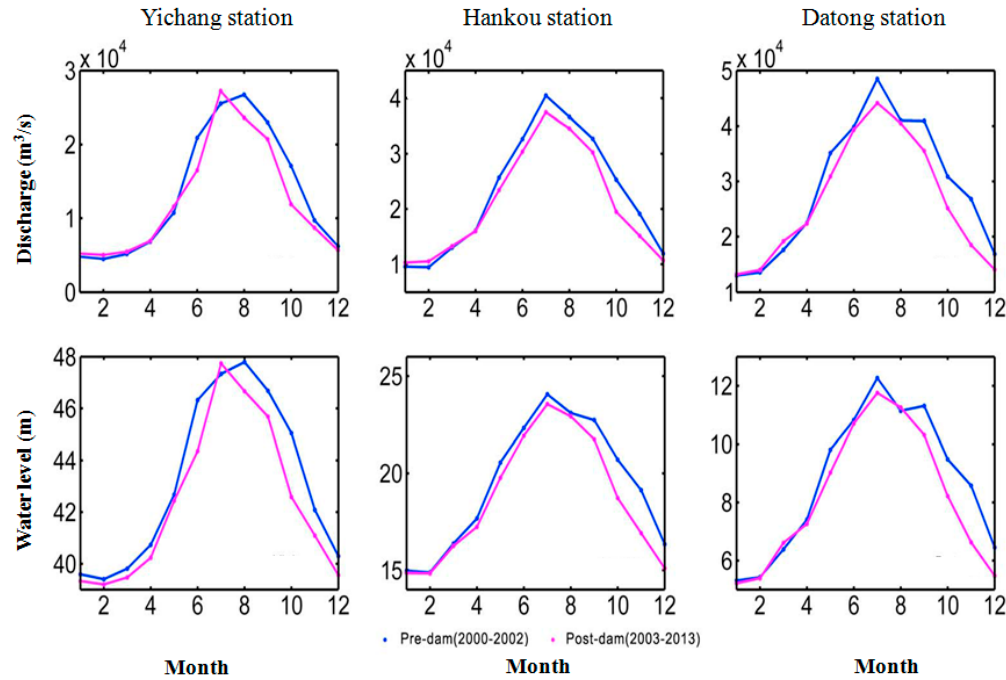
Figure 3. Monthly mean discharge and water level at Yichang, Hankou and Datong station ( modified from Mei et al. [21] ).